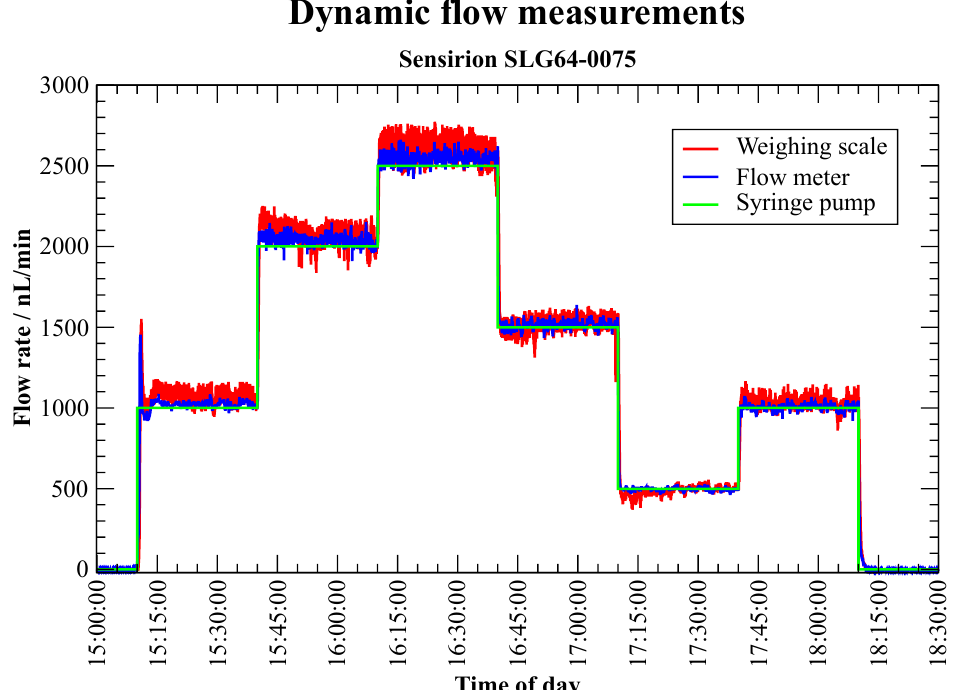
Figure 11. Results of the dynamic flow test. The green curve shows the (predefined) flow rate of the Cetoni pump, the blue curve, the measured data from the Sensirion flow meter (DUT) and the red curve, the flow rate of the scale converted from the mass